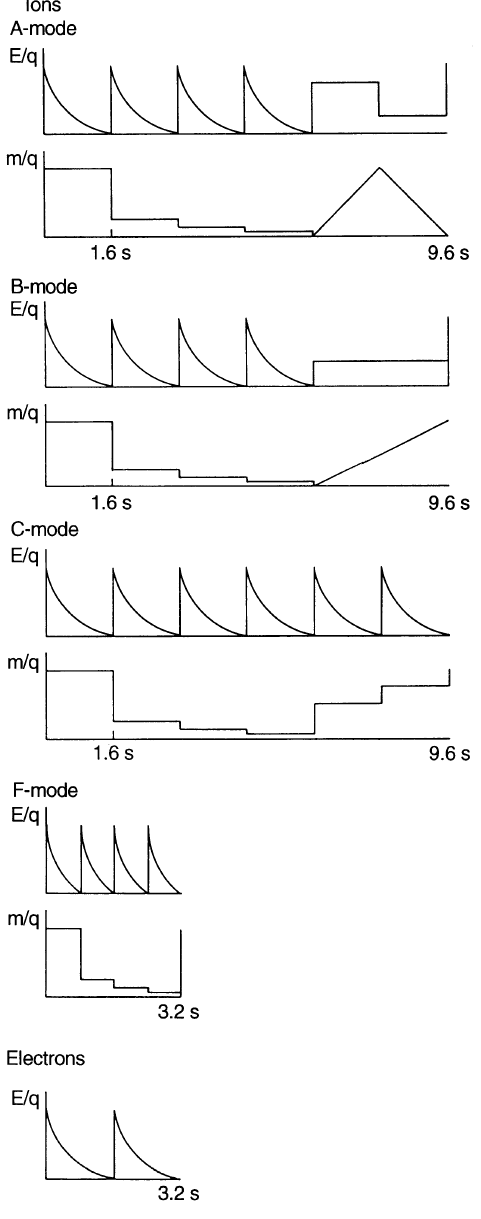
Fig. 7. Ion and electron measurement modes